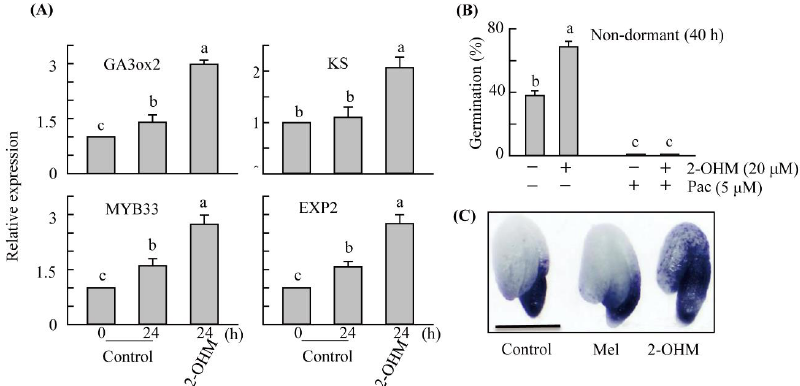
Figure 2. ( A ) Effects of 2-hydroxymelatonin (2-OHM) on the expression of gibberellic acid (GA)- related genes, ( B ) the GA biosynthesis inhibitor paclobutrazol, and ( C ) superoxide levels during seed imbibition. Non-dormant Arabisopsis thaliana wild-type (WT) seeds were imbibed in 2 mM MgCl 2 (5 mM MES, pH 5.7) (Control) with or without 2-OHM (20 μ M) for 1 day. Gene expression levels were analyzed by quantitative reverse-transcription polymerase chain reaction (qRT-PCR). Paclobutrazol (5 μM) was applied to determine whether 2 -OHM-induced seed germination en- hancement was dependent on GA. The germination percentage was determined at 40 h after imbi- bition. Nitrotetrazolium blue (NBT) staining was conducted to assess O 2. − accumulation. Bar = 0.3 mm. Error bars indicate standard deviation (SD) of three biological replicates. Different letters indi- cate significant differences ( p < 0.05; ANOVA, followed by Tukey’s HSD post hoc tests). Pac, paclo- butrazol; Control, 2 mM MgCl 2 ; Mel, melatonin (20 μ M); 2-OHM, 2-hydroxymelatonin (20 μ M). GA3ox2 , gibberellin 3-oxidase 2 (AT1g80340); MYB33 , myb family transcription factor 33 (AT5g06100); KS , ent-kaurene synthase (AT1g79460); EXP2 , expansin 2 (AT5g05290); 18s rRNA (AT1g80340).